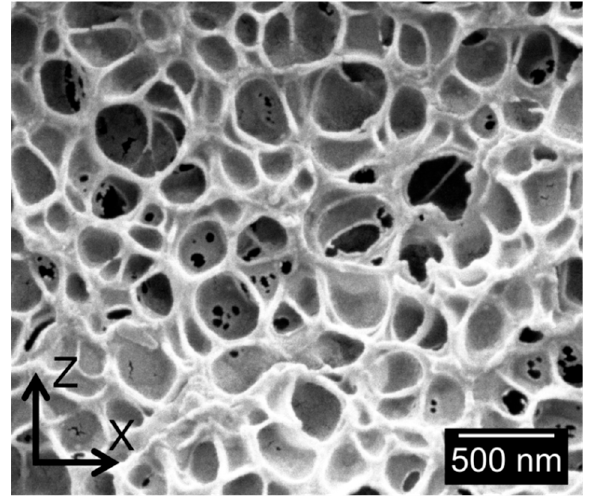
Figure 3. Micrograph of cellular structure of Sample 7.